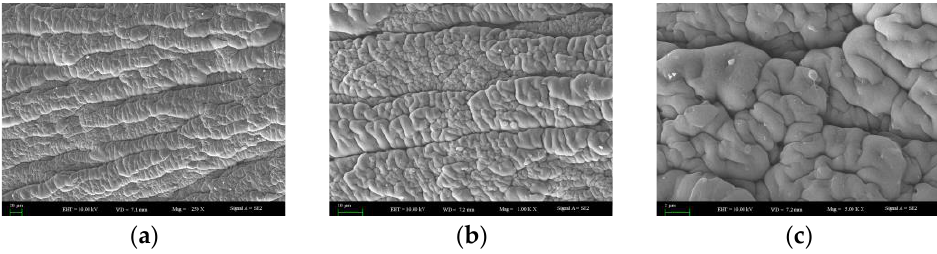
Figure 16. Microstructure of fracture surface of the PET specimens. ( a ) SEM image of 250 times; ( b ) SEM image of 1000 times; ( c ) SEM image of 5000 times.